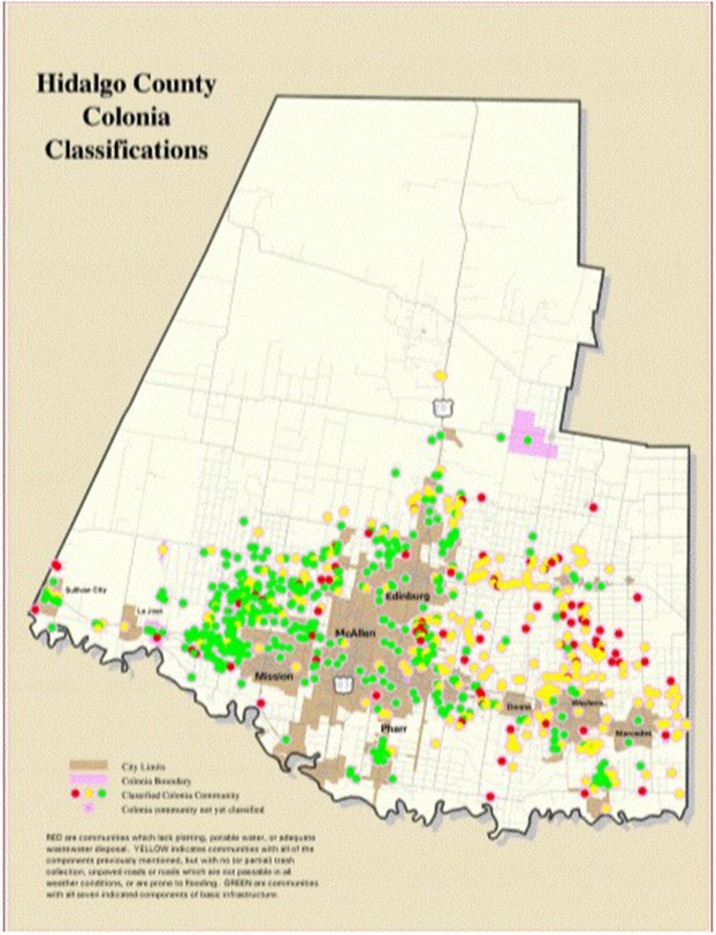
Colonia map in Hidalgo County. Benefit Colonias (3).